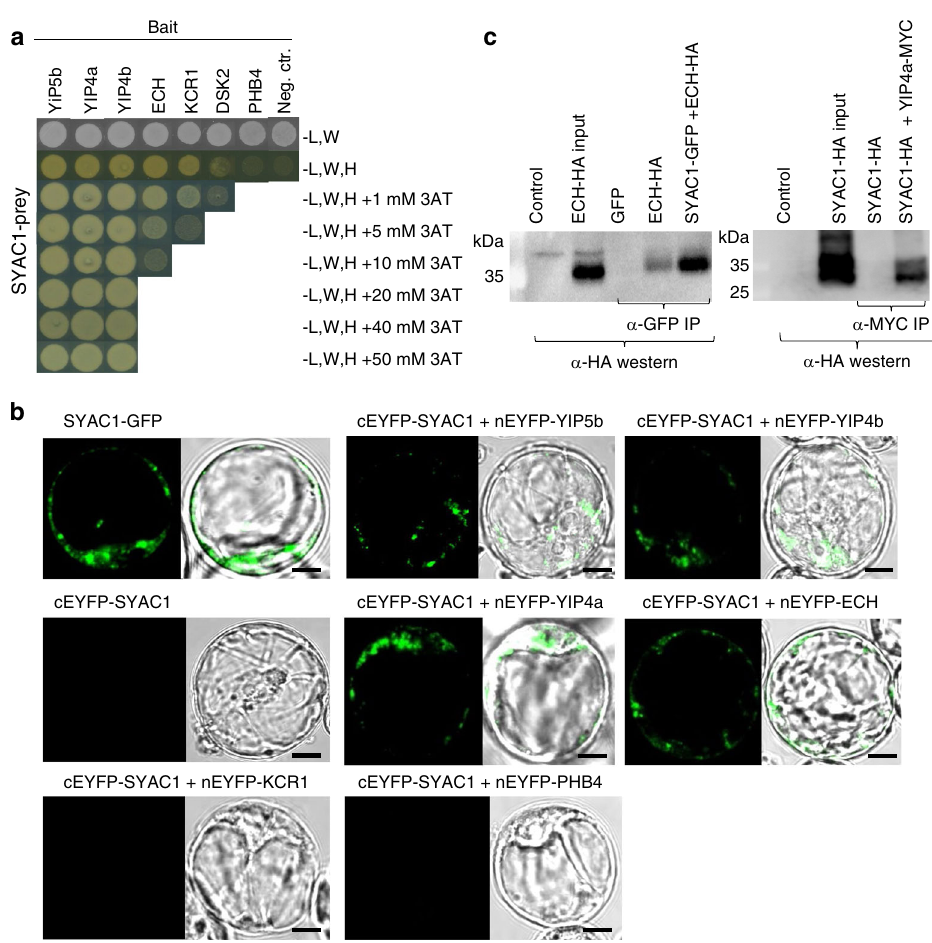
Fig. 4 SYAC1 interacts with YIP4a, YIP4b, YIP5b, and ECH protein. a Y2H assay con fi rms SYAC1 (prey, cloned in pDEST-GADT7) interaction with YIP4a, YIP4b, YIP5b, and ECH. Weaker interaction detected for KCR1 and DSK2, whereas no interaction found between SYAC1 with PHB4 protein. Yeast cells were grown on SD-LWH minimal media without histidin (H), leucin (L) and tryptophan (W), supplemented with 3-amino-1,2,4-triazole (3AT). Empty pDEST-GBKT7 (bait) vector was used as negative control. b Bimolecular fl uorescence complementation (BiFC) assay in Arabidopsis root cell culture protoplasts reveals interaction between SYAC1 and YIP4a, YIP4b YIP5b, ECH, no interaction detected with KCR1, and PHB4 proteins. SYAC1-GFP and SYAC1-cEYFP (C-terminal part of EYFP) were used as a positive and negative control, respectively. Scale bar 10 µ m. c Co-immunoprecipitation (Co-IP) assay of SYAC1-GFP with ECH-HA and SYAC1-HA with YIP4a-MYC transiently expressed in Arabidopsis root cell culture protoplasts. The anti-GFP and anti-MYC antibodies immunoprecipitates were analyzed in a western blot assay with anti-HA